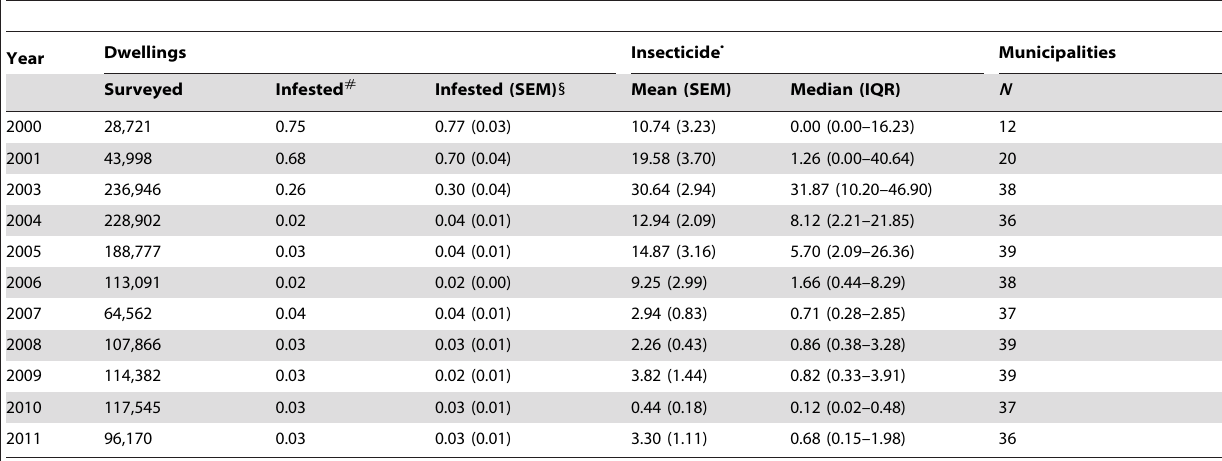
Table 1. Dwelling infestation by triatomines and vector control effort across 39 municipalities in Chagas disease risk areas, Cochabamba, Bolivia, 2000–2011*.